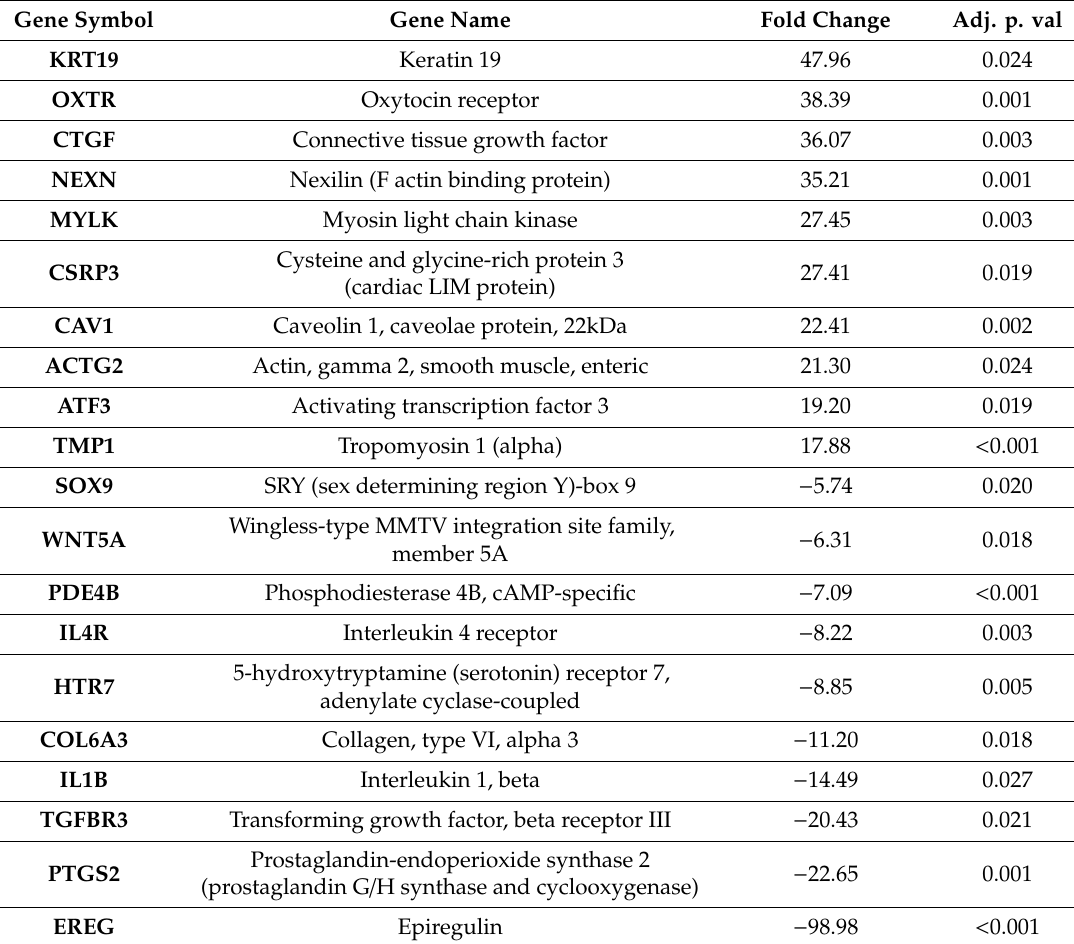
Figure 1. Heatmaps presenting di ff erentially expressed genes involved in “muscle cell development”, “muscle cell di ff erentiation”, “muscle contraction”, “muscle organ development”, “muscle organ morphogenesis”, “muscle structure development”, “muscle system process” and “muscle tissue development” based on GO BP (Gene Ontology Biological Process) terms. Each row on the y -axis represents a single transcript. The red colour indicates the downregulated genes while the green the upregulated genes. Table 2. The 10 most significantly upregulated and 10 most significantly downregulated genes involved in muscle cells morphogenesis, structure, development and di ff